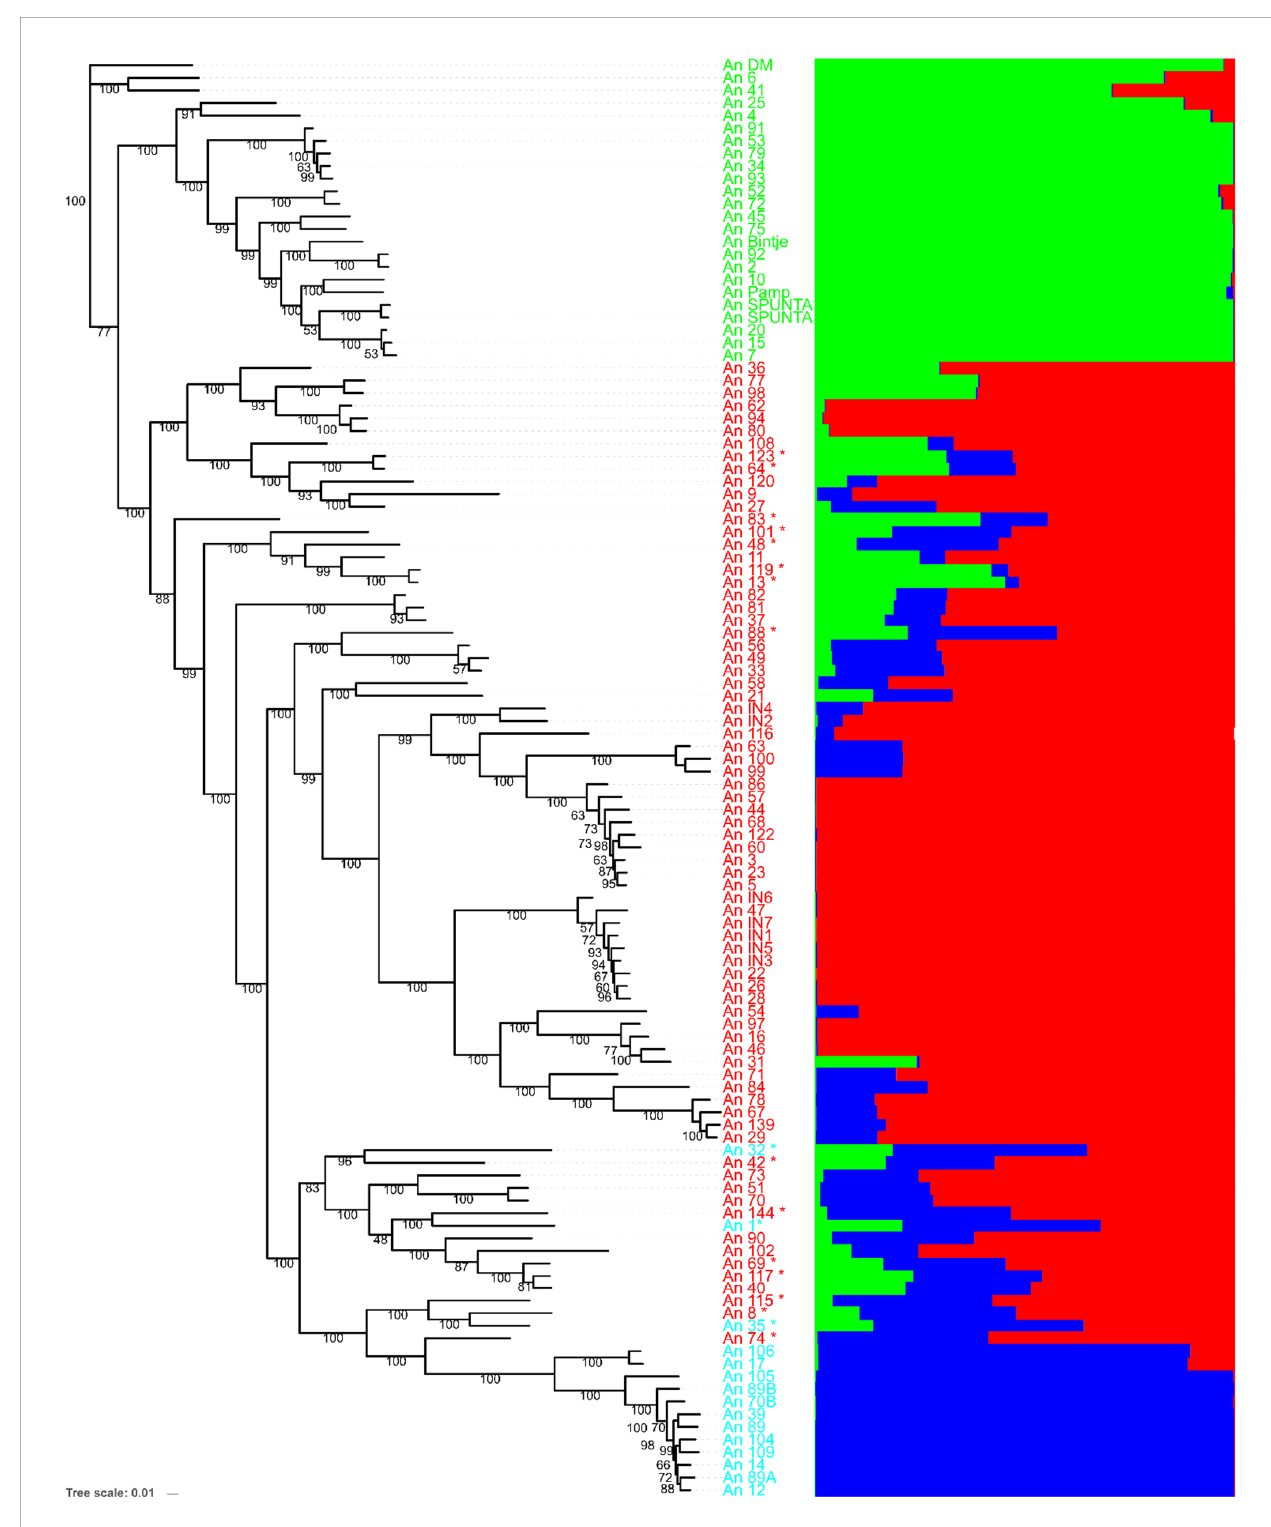
Figure 3. STRUCTURE plot of the 114 potato accessions based on 5035 SNP markers. Each column corresponds to one accession and is partitioned into colored segments that are in proportion to the estimated membership of the three subpopulations. Maximum likelihood trees are shown on the left side. Accessions were labeled by color according to STRUCTURE results. Accessions with a membership proportion lower than 0.6 were labeled with an asterisk.